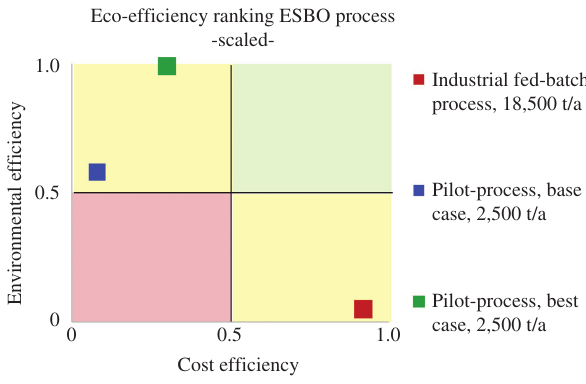
Figure 10 Eco-efficiency ranking of three discontinuously or con-